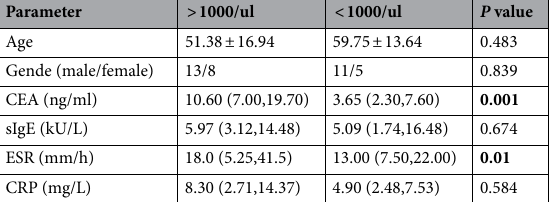
Table 5. Basic information of the two groups of ABPA